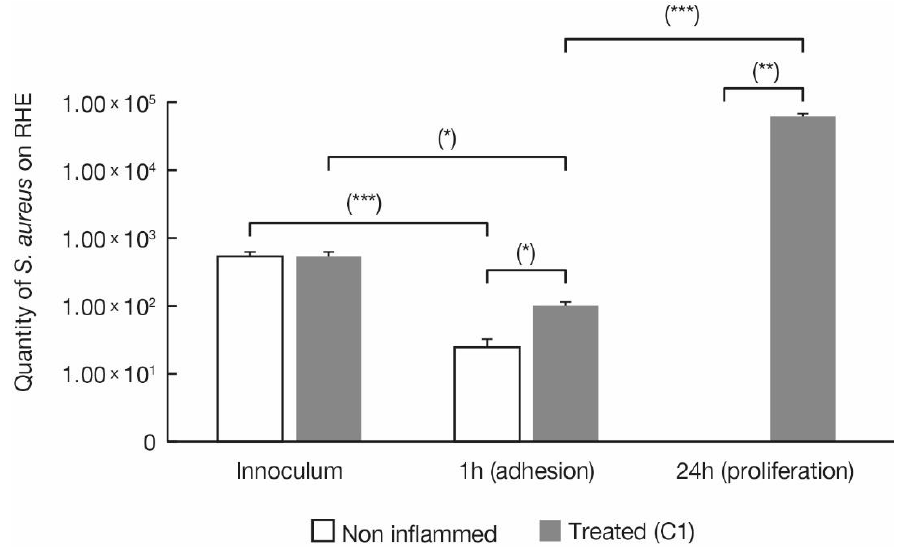
Figure 4. Promotion of S. aureus adhesion and proliferation by Th2 cytokines on reconstructed human epidermis (RHE) surface. S. aureus inoculum was topically applied on the surfaces of non-treated RHEs (open bars) and RHEs treated with 5 ng/mL of Th2 cytokines (C1; gray bars). The number of bacteria was measured 1 h and 24 h after inoculation (n = 3). Mean ± SEM, Student t test; *, p < 0.05; **, p < 0.01; ***, p < 0.001.